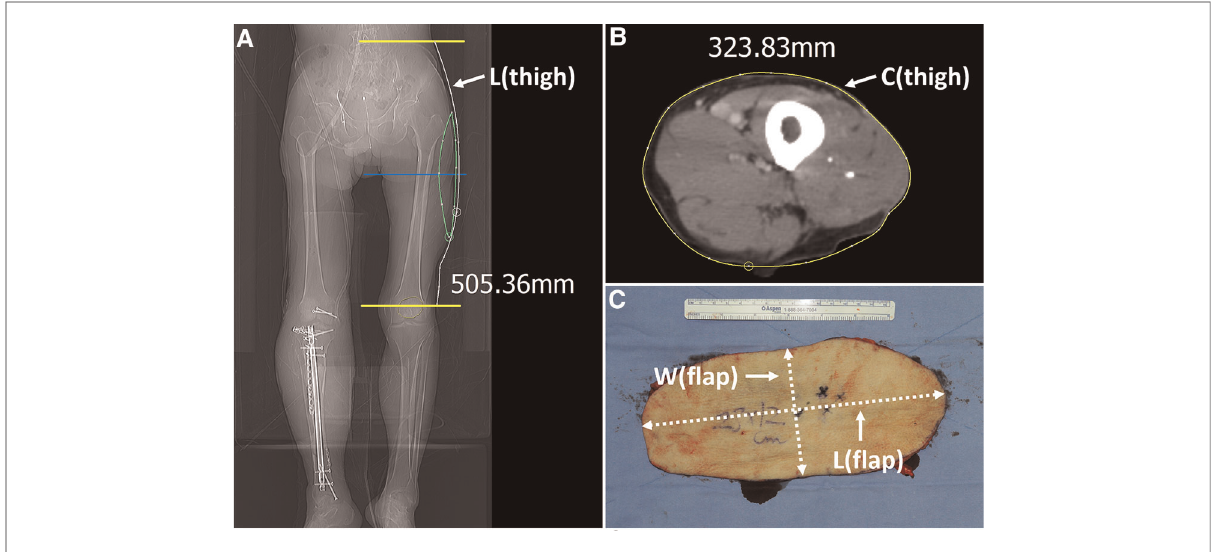
FIGURE 2 Measurement of the length of the thigh regions and the harvested fl ap to calculate length and width ratio. ( A ) The length between ASIS and patella center, which is named thigh length, was measured using a digital tool in the PACS. ( B ) The thigh circumference was measured using the curve measurement tool in PACS. ( C ) The major and minor axis length was measured from the harvested fl ap. ASIS, anterior superior iliac spine; PACS, picture archiving and communication system; L(thigh), length from ASIS to patella center; C(thigh), circumference of the thigh at the mid-level between ASIS and patella center; W( fl ap), width of the fl ap or length of the minor axis of the fl ap; L( fl ap), length of the major axis of the fl